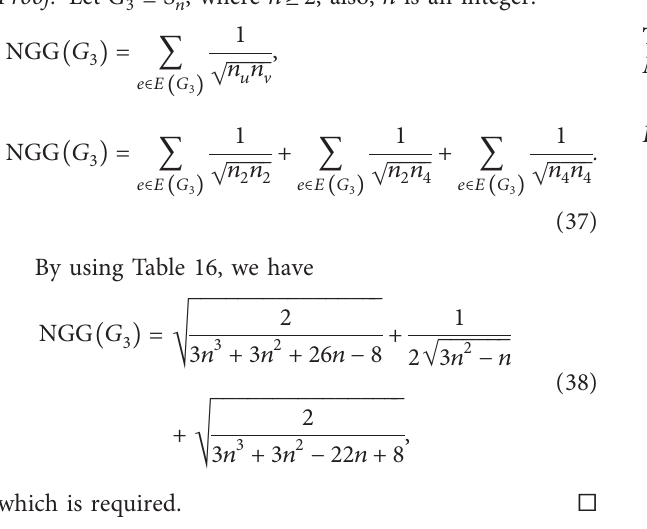
which is required. □